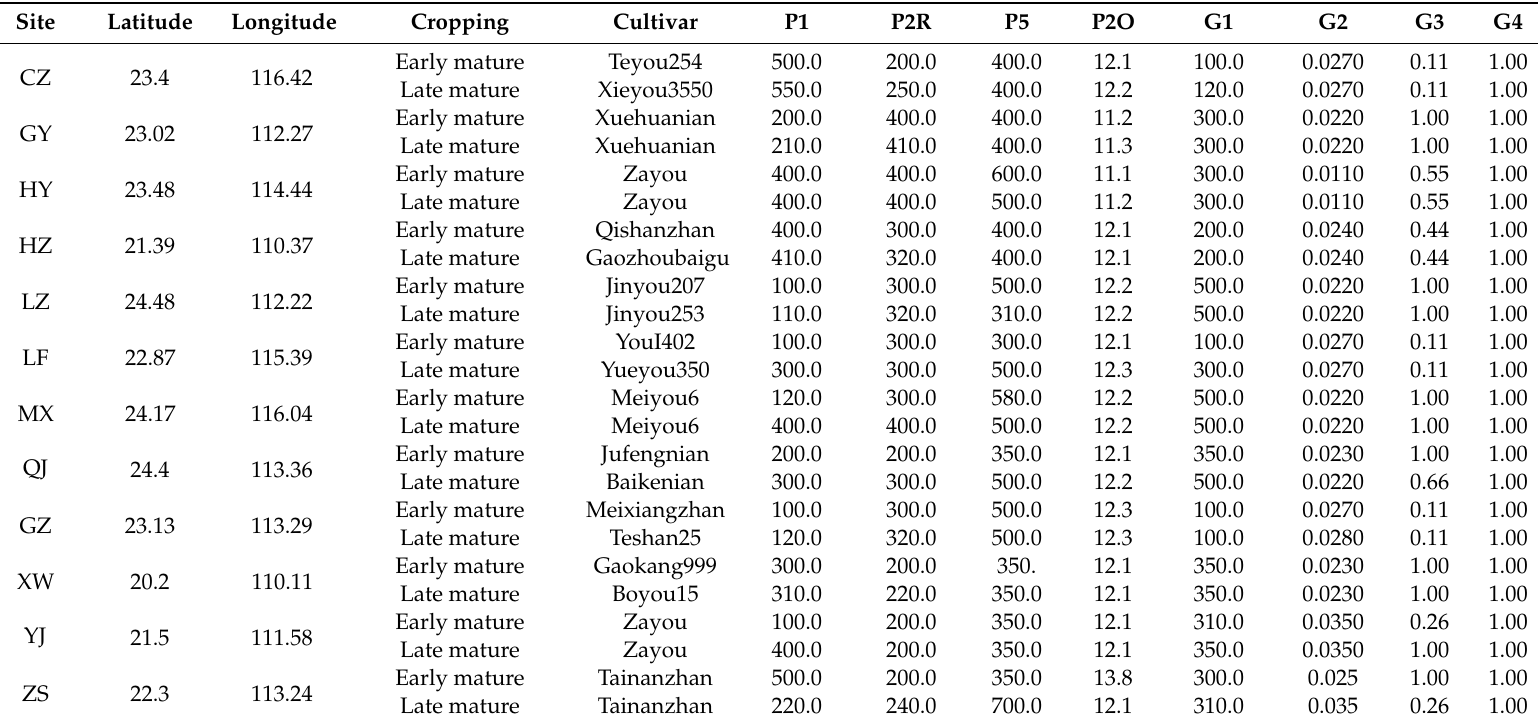
Table A3. The detail of the site, cropping system, rice cultivar name and